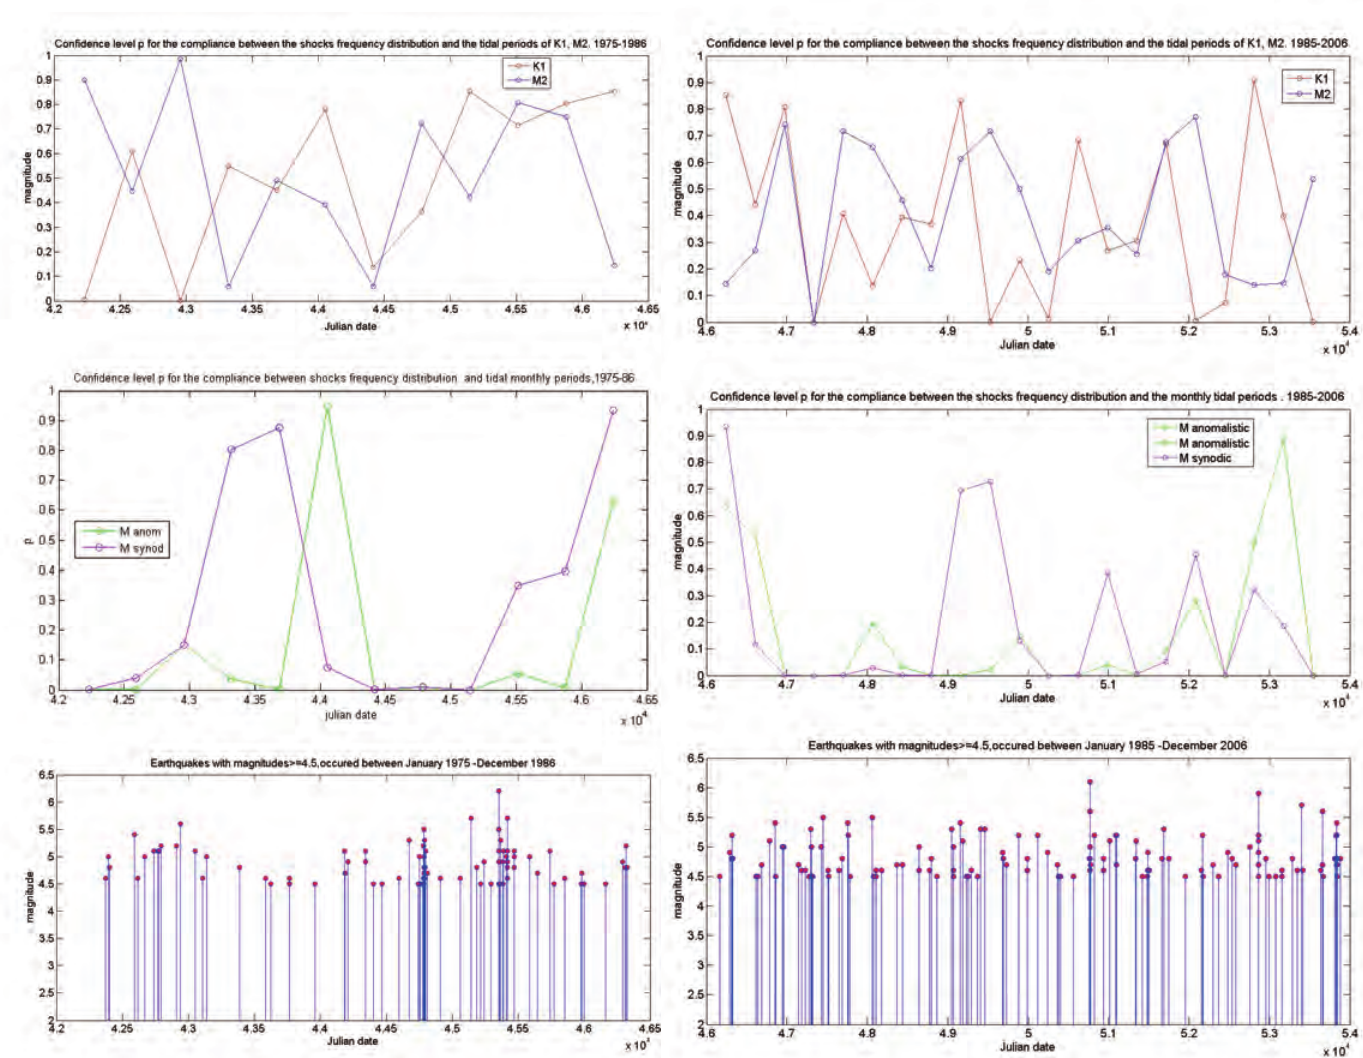
Figure 8 ( left ) . Confidence levels for compliance between the frequency distribution of the shock occurrence and (a) K1, M2 tidal periods. (b) M-anomalistic and M-synodic periods. (c) Earthquakes with magnitudes $ 4.5 for the time from January 1975 to December 1986. Figure 9 ( right ) . Confidence levels for compliance between the frequency distribution of the shock occurrence and (a) K1, M2 tidal periods. (b) M- anomalistic and M-synodic periods. (c) Earthquakes with magnitudes $ 4.5 for the time from January 1985 to December